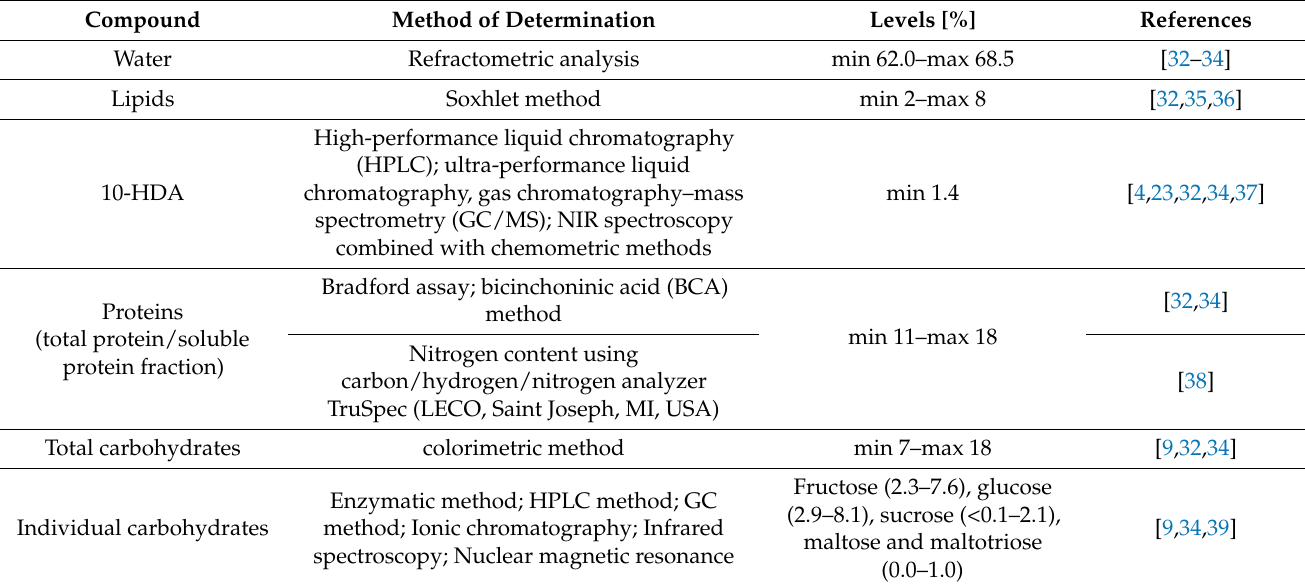
Table 1. Nutritional requirements for quality assurance of